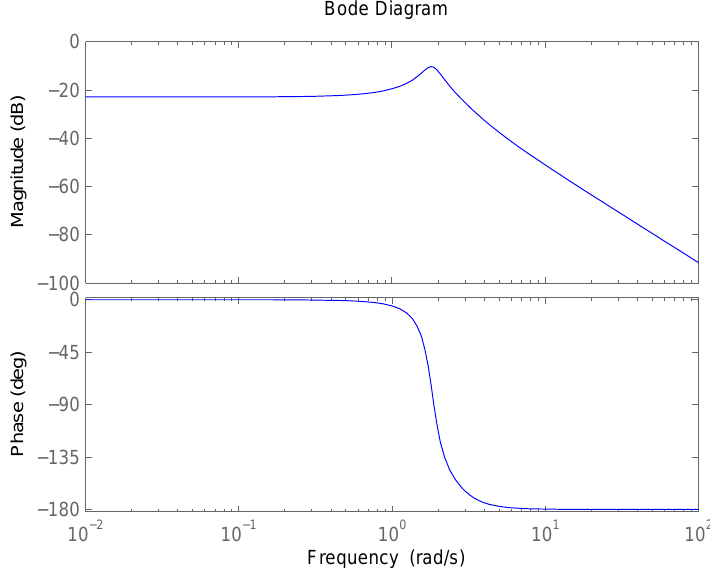
Figure 5. Bode diagram of the float dynamics (6) normalized to 1 rad/MNm.